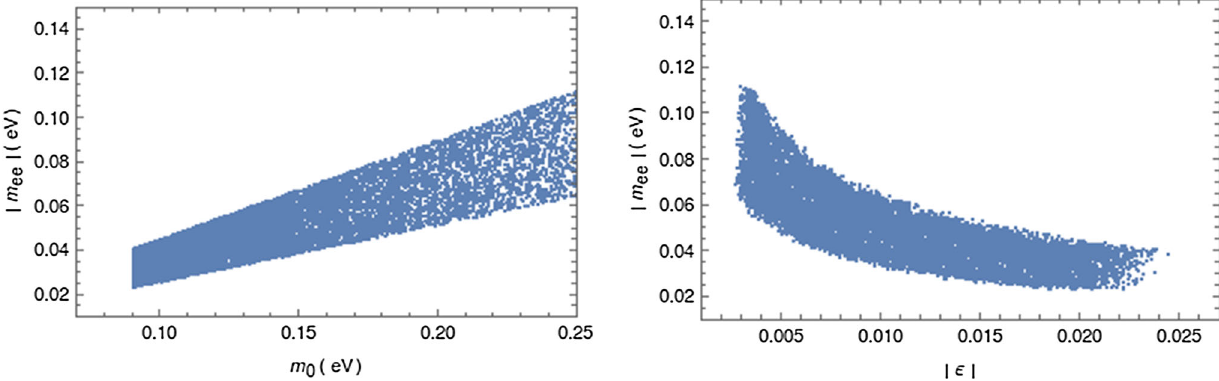
Fig. 6 Neutrino mass scale and the sum of the neutrino masses versus | m 0 ν